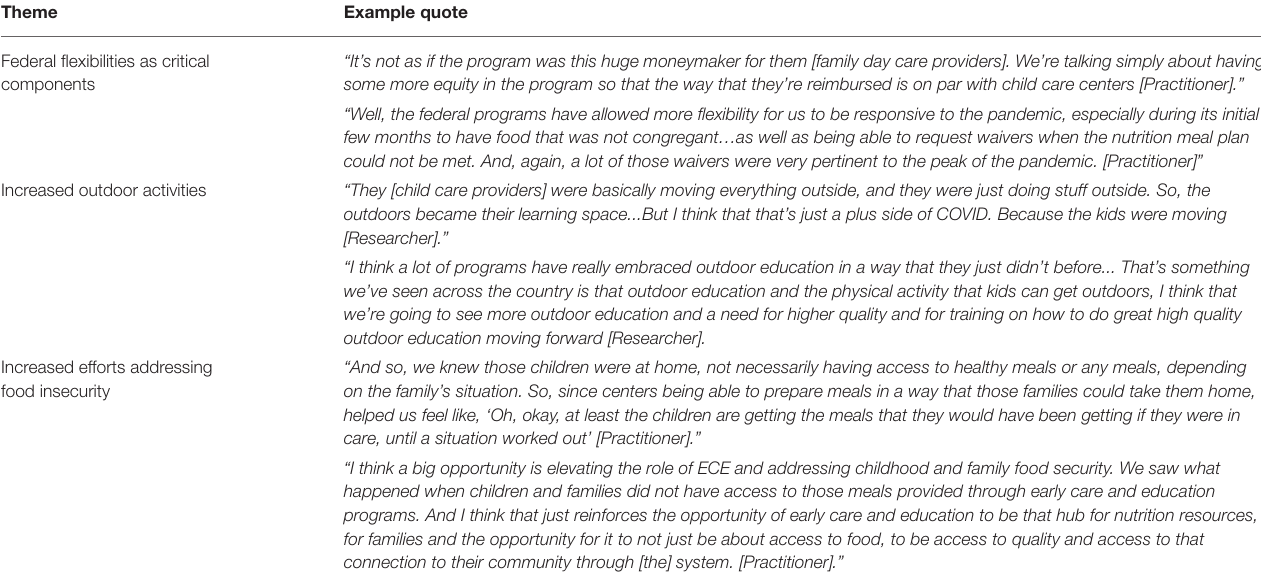
TABLE 3 | Key informant themes and quote snapshot: opportunities that emerged during COVID-19.